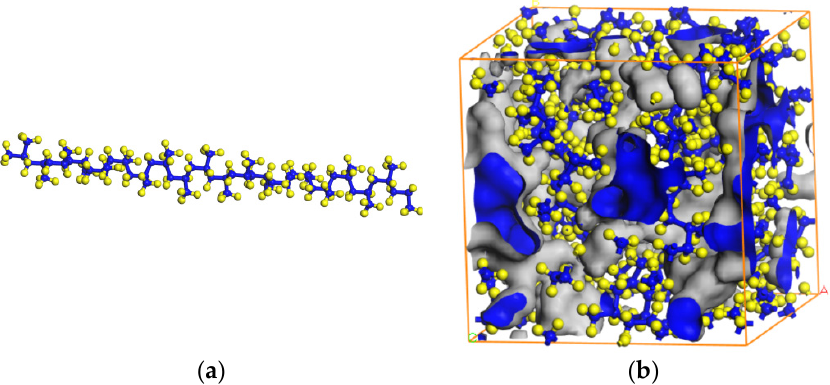
Figure 11. Molecular model. ( a ) molecular chain structure of PP; ( b ) the free volume of PP.